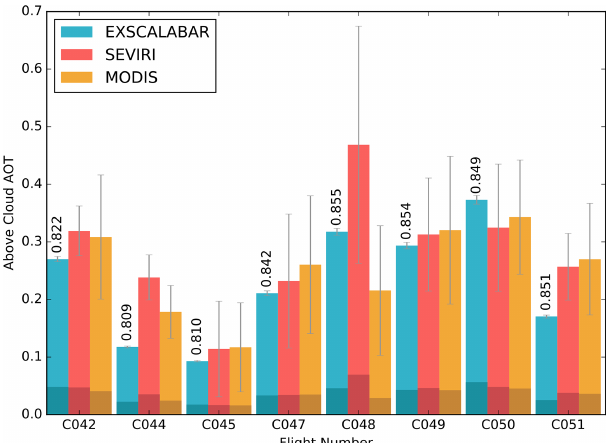
Figure 8. Comparison of the above-cloud AOT (lighter shades) and AAOT (darker shades) retrieved by SEVIRI and MODIS and mea- sured by EXSCALABAR during descent profiles. The error bars represent the uncertainties of the EXSCALABAR measurements and the standard deviation of the satellite product within a 60km ra- dius around the aircraft measurements for SEVIRI and MODIS. The SSA has been calculated at 0.55µm from the EXSCALABAR ob- servations and included as an annotation over the EXSCALABAR above-cloud